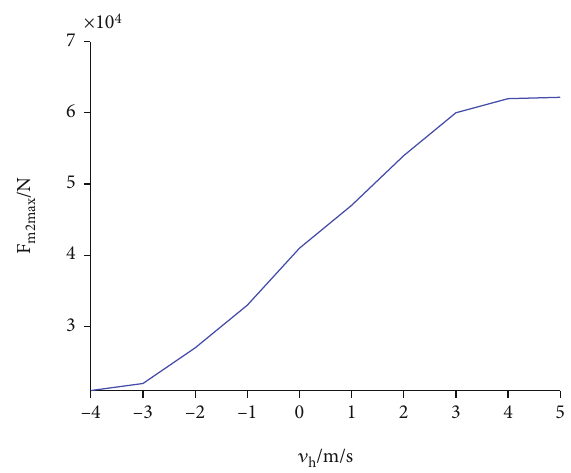
Figure 7: The maximum force on the primary strut 2 vs. the initial horizontal